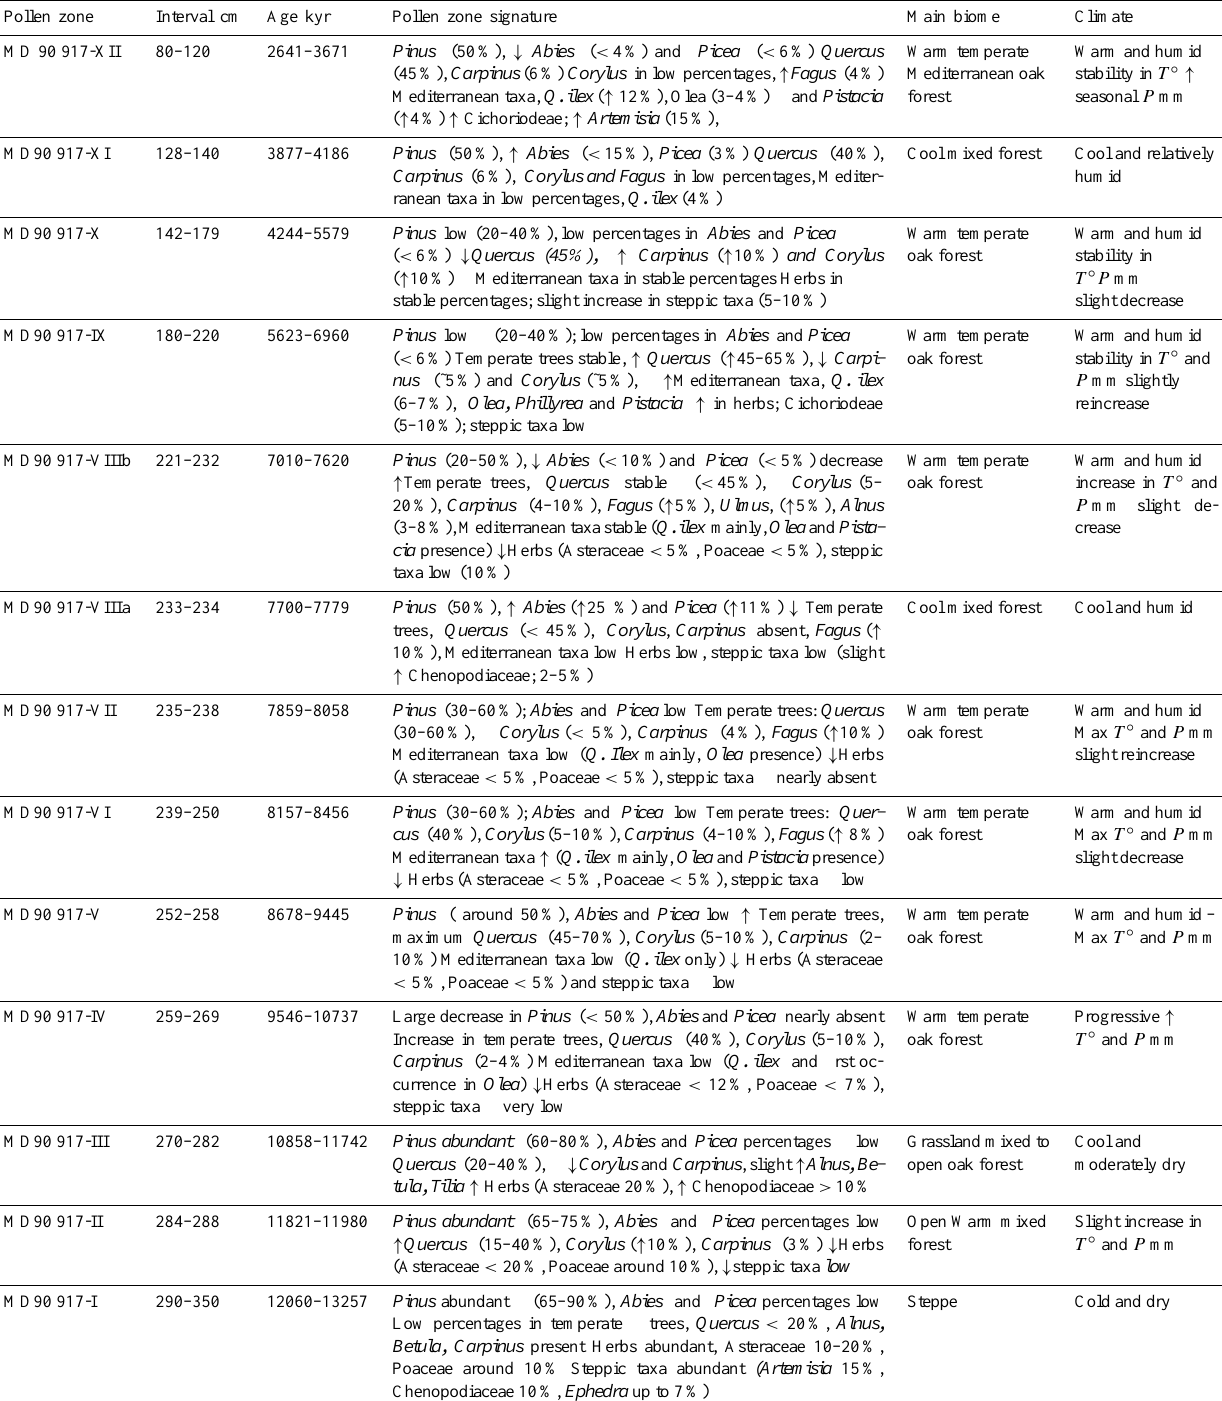
Table 2. Short description of the pollen zonation of the MD 90-917 pollen